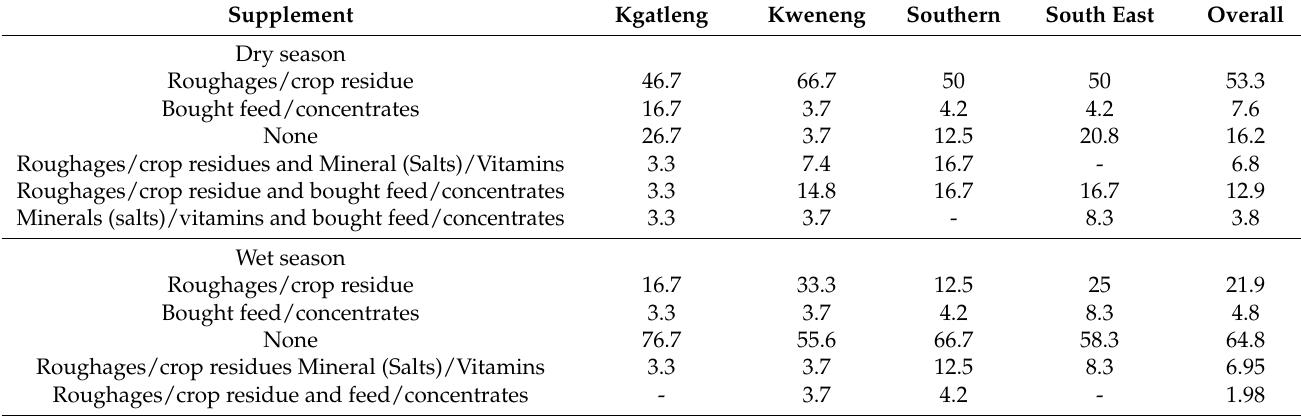
Table 6. Frequency (%) of supplementary regime used on sheep during the wet and dry